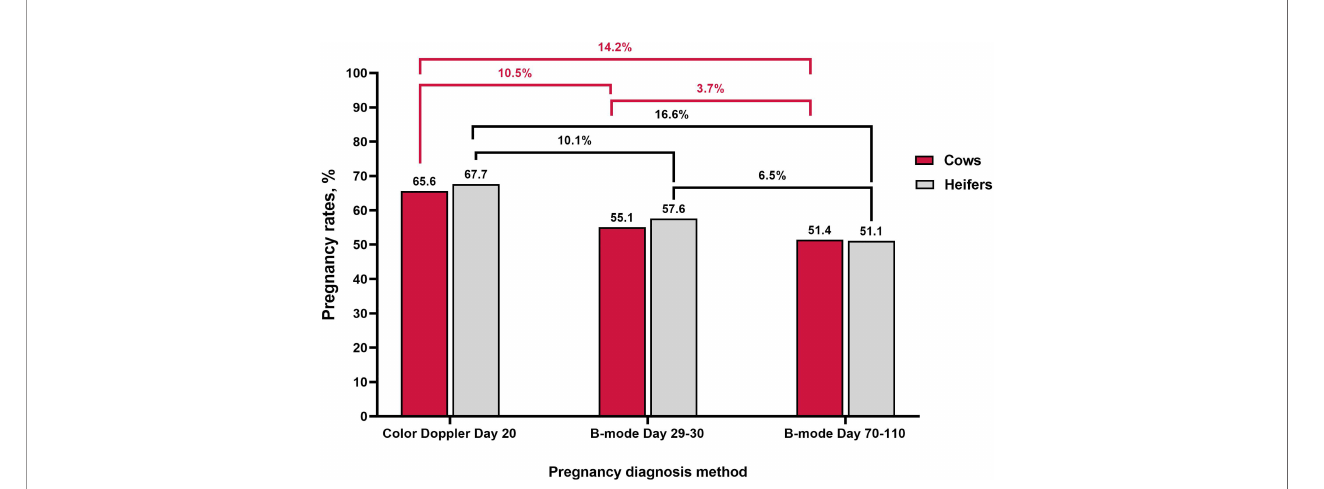
FIGURE 2 | Changes in the percentage of pregnancies during early gestation using luteal color Doppler ultrasonography on day 20 and B-mode ultrasonography on days 29-30 and 70-110. Data adapted from Melo et al., 2020 and Holton et al., 2022a; Holton et al., 2022b using beef cows and